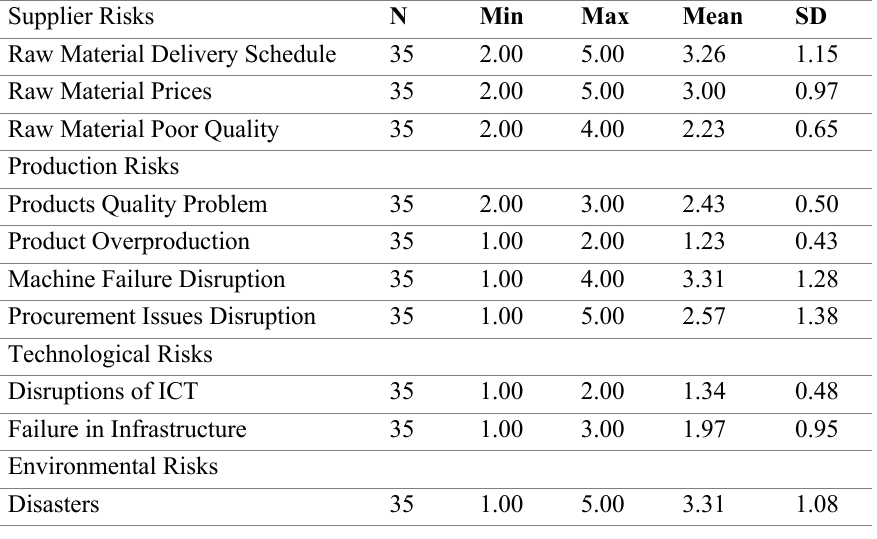
Table 3: Descriptive statistics of supply chain risks